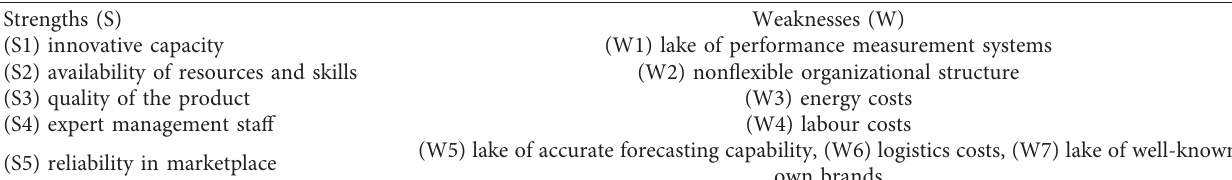
Table 3: SWOT matrix.